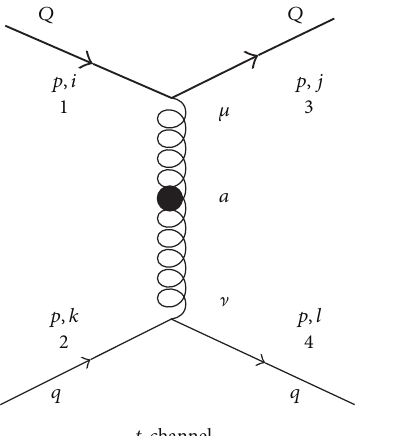
Figure 21: 𝑄𝑞 → 𝑄𝑞 Feynman diagram. Bold lines are for heavy quarks ( 𝑄 ).